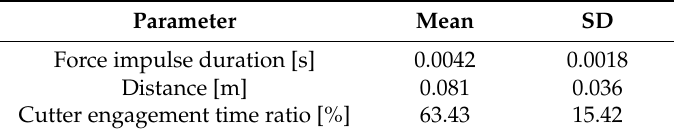
Table 1. Mean values and standard deviations of the measured parameters.